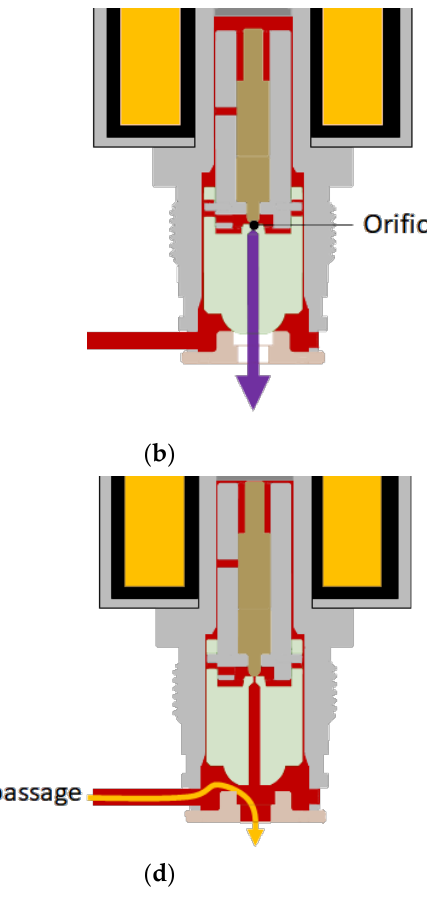
Figure 2. Principle of the pilot-operated solenoid valve: ( a ) initial state; ( b ) application of an electric voltage; ( c ) pressure equilibrium state; ( d ) opening of the flow passage.